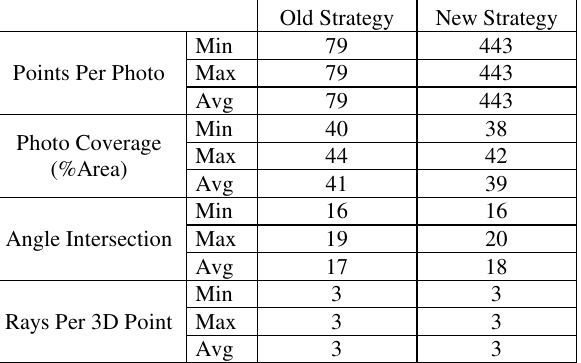
Table 5. Comparison summary of the Seahorse